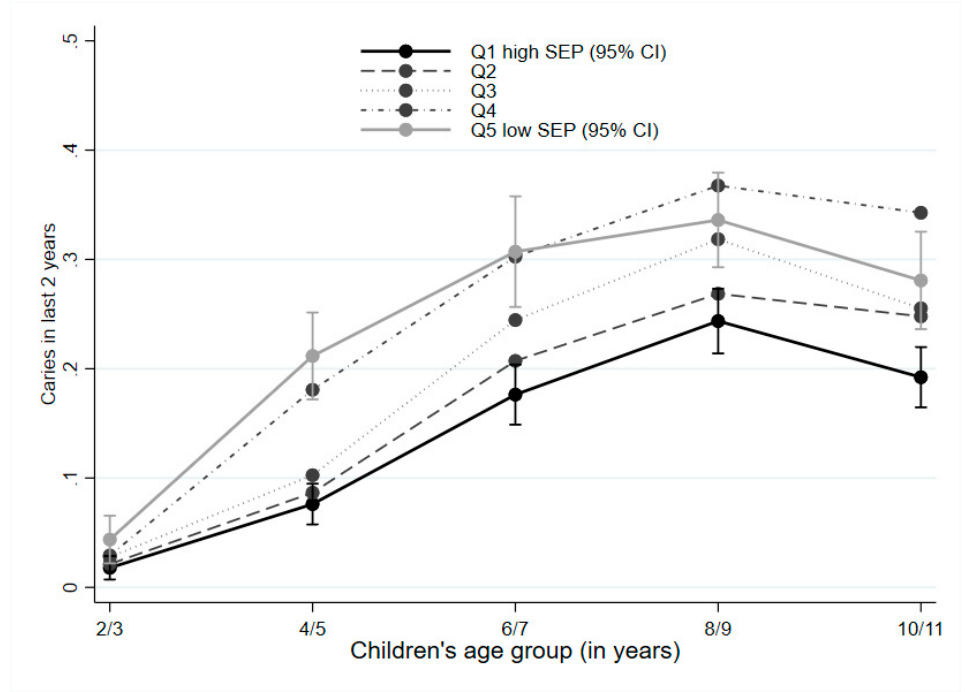
Figure 2. Proportion of children with caries in last two years, according to socioeconomic position.